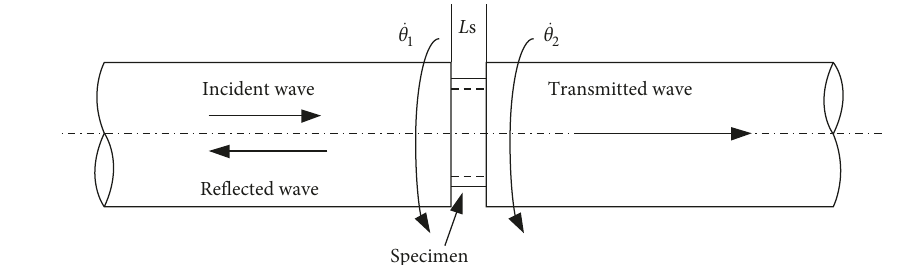
Figure 12: Sketch of the specimen in the TSHB experiment [57].